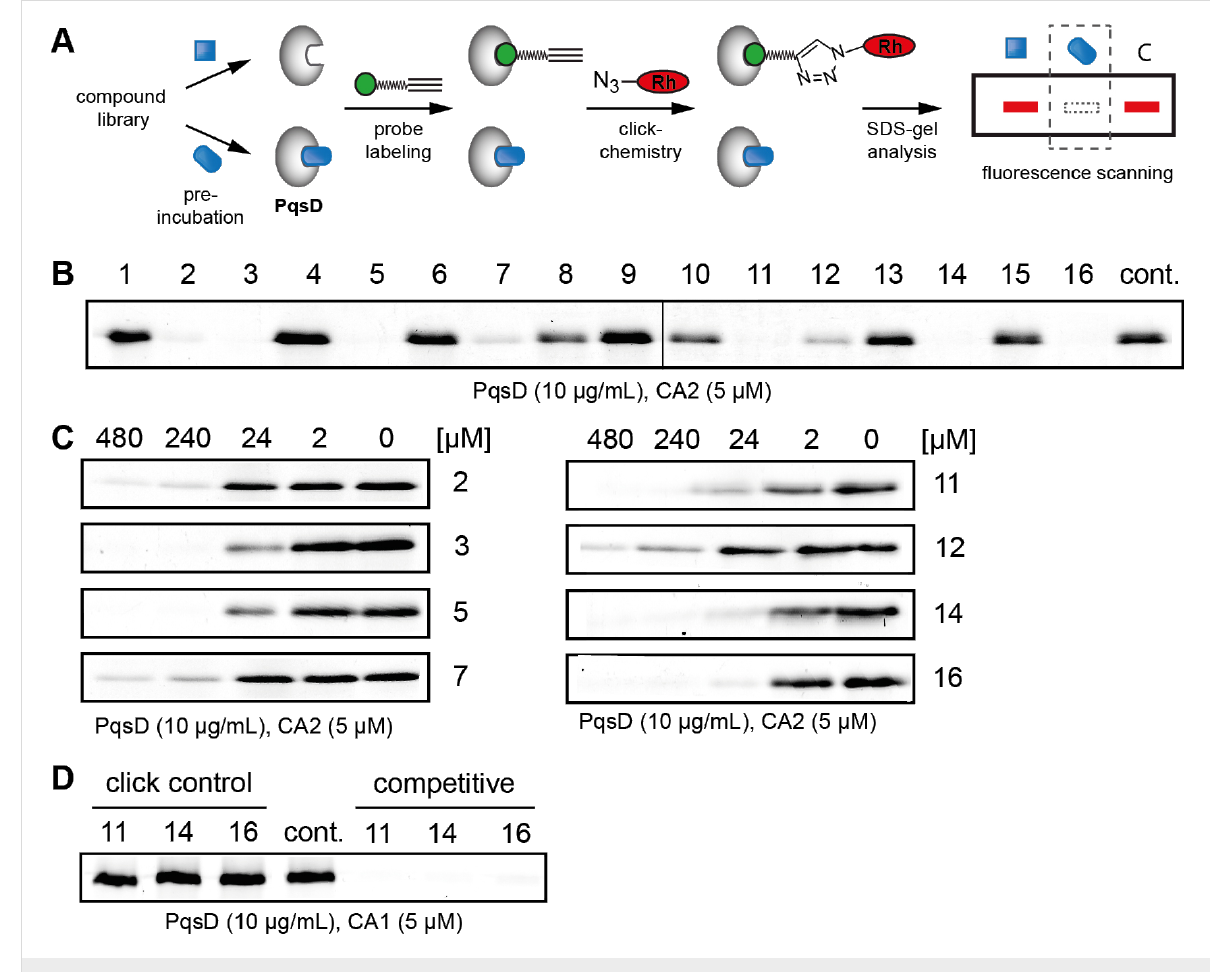
Figure 5: Competitive profiling platform. A) Schematic representation of the competitive labelling strategy with an alkyne probe (green) and potential inhibitors (blue). Rh = rhodamine. B) Initial screening of our small library of HHQ ( 1 – 9 ) and PQS ( 10 – 16 ) analogues against the active site specific chemical probe CA2 . C) Concentration dependent competition experiment where the probe concentration is held constant and PqsD is pre-treated with varying inhibitor concentrations. D) Click chemistry control where the compounds were added shortly before Cu II -salt addition in the click protocol. Cont.: DMSO